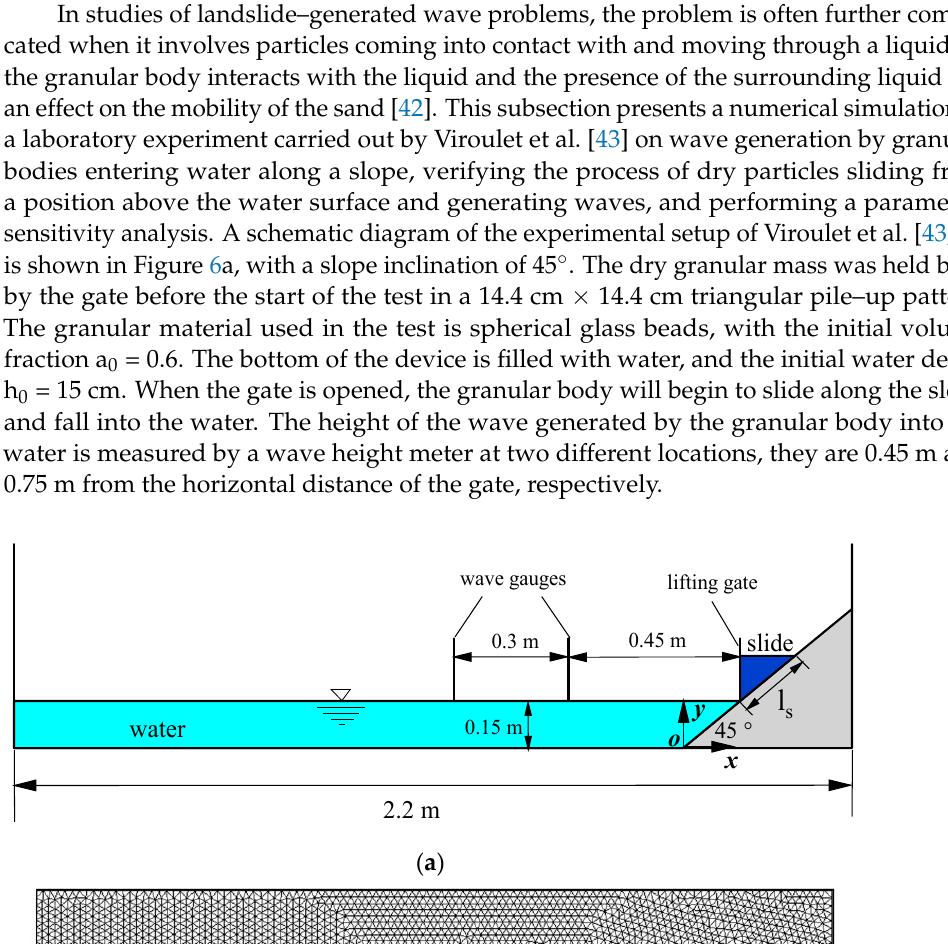
Figure 5 . Thickness pro fi le comparison of experimental and numerical results. Figure 5. Thickness profile comparison of experimental and numerical results.